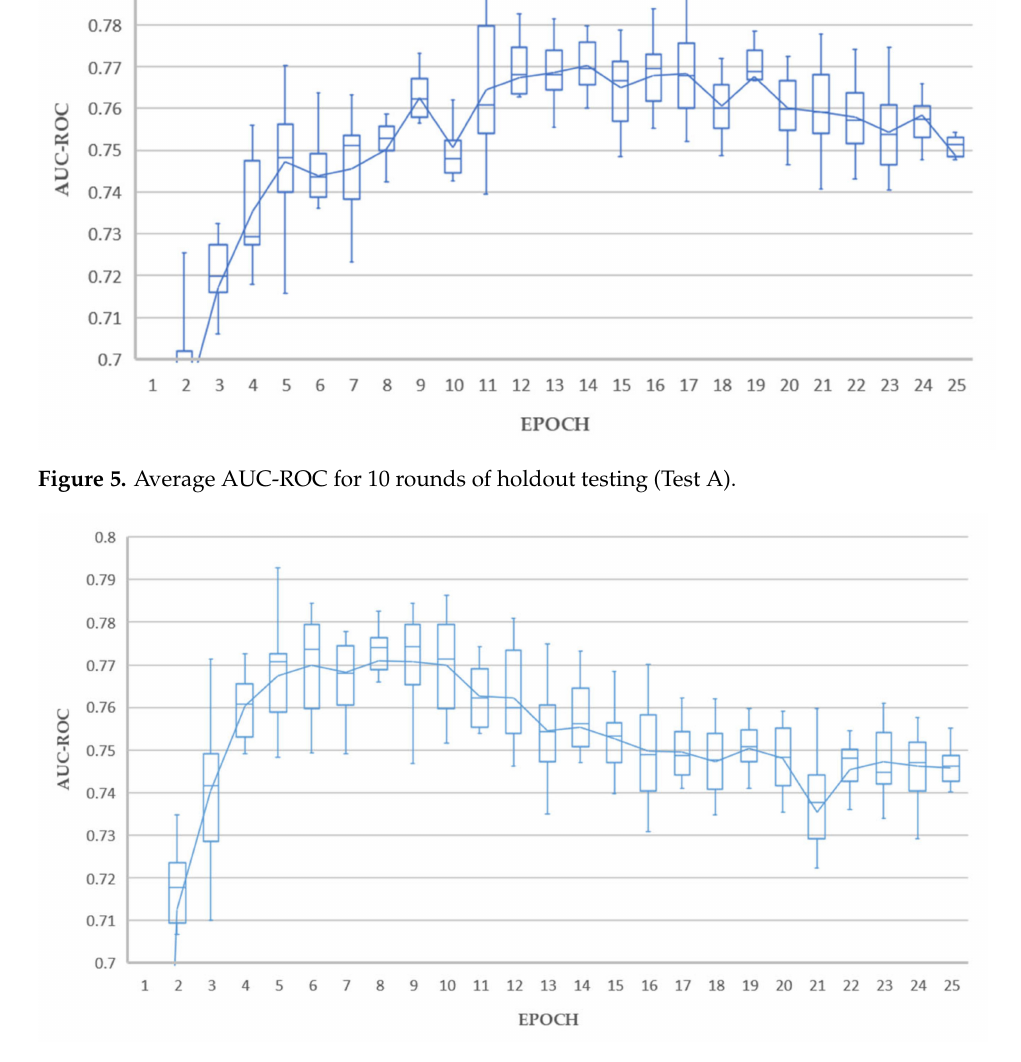
Figure 6. Average AUC-ROC for 10 rounds of holdout testing (Test